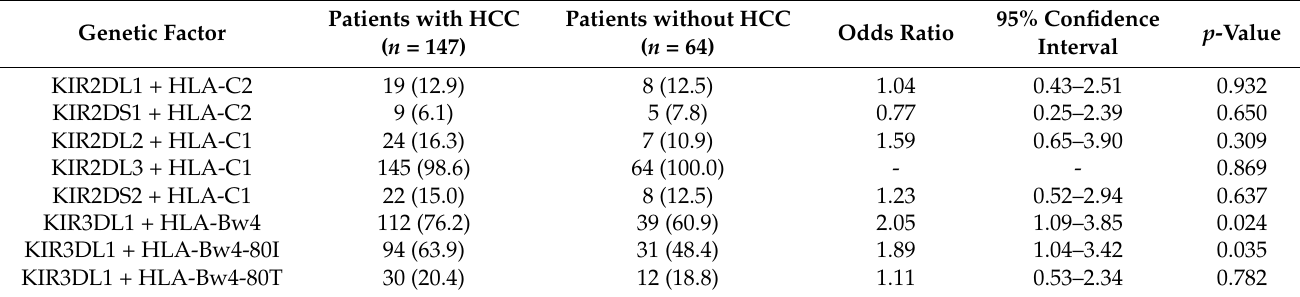
Table 3. Frequency of killer cell immunoglobulin-like receptor (KIR)–HLA pairs in patients with and without hepatocellular carcinoma (HCC).